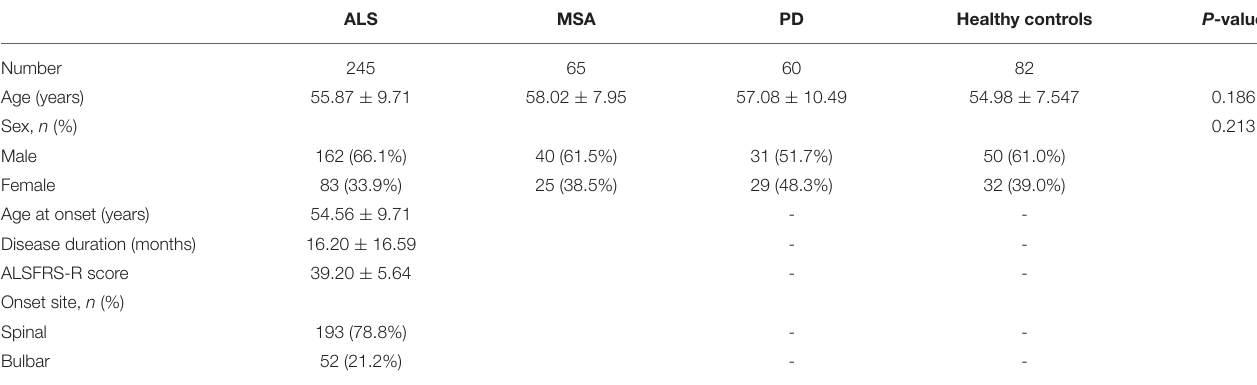
TABLE 1 | Characteristics of patients with ALS, MSA, and PD and HCs. ALS MSA PD Healthy controls P -value Number 245 65 60 82